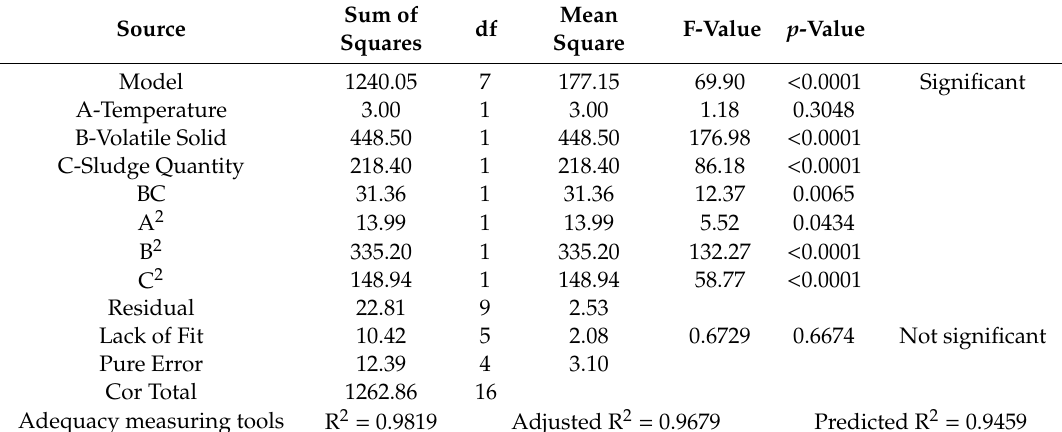
Figure 9. Perturbation plot showing the effect of all factors on CH 4 %.